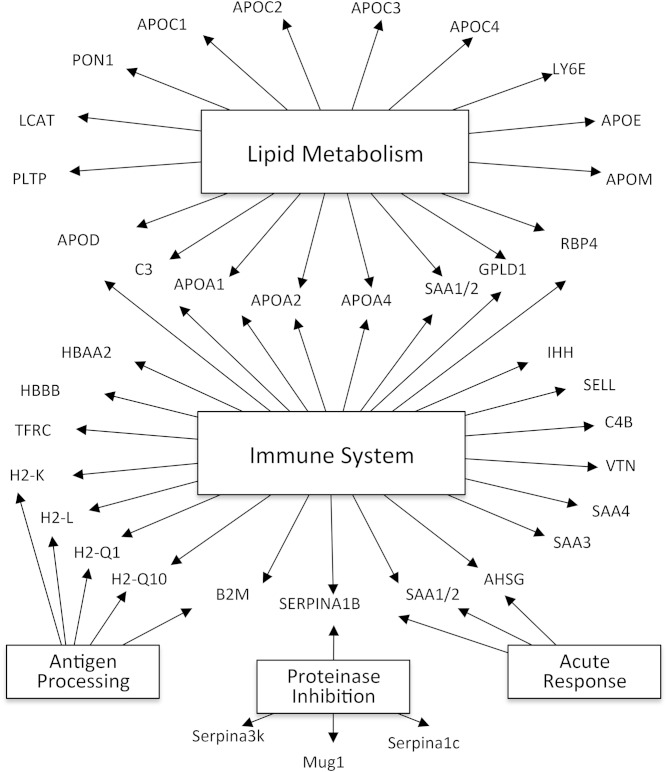
Global view of biological processes and molecular functions of HDL proteins. Proteins detected in HDL were associated with biological functions using Gene Ontology process annotations. This approach demonstrated significant overrepresentation of proteins involved in several categories, including lipid metabolism (P = 10−15), the immune response (P = 10−6), protease inhibitor activity (P = 10−7), antigen processing (P = 10−3), and the acute-phase response (P = 10−5).